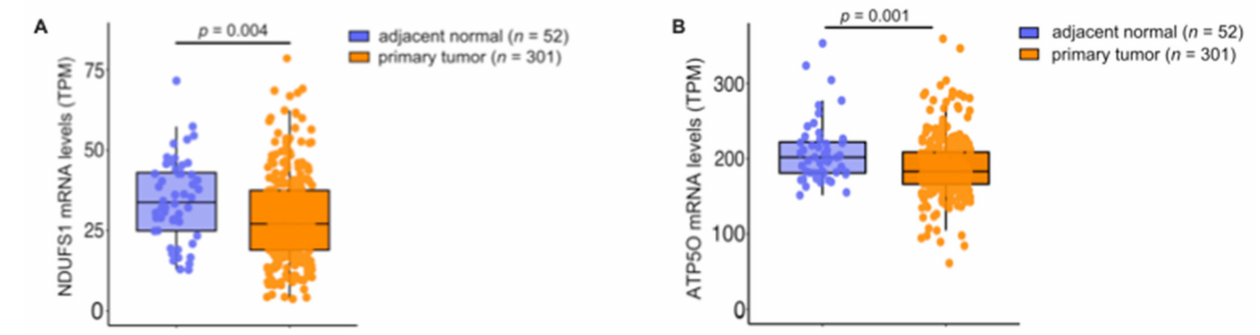
Figure A4. ( A ) NDUFS1 mRNA expression levels (TPM) analyzed from TCGA-PRAD primary tumor tissue ( n = 301) and adjacent normal tissue ( n = 52). ( B ) ATP5O mRNA expression levels (TPM) analyzed from TCGA-PRAD primary tumor tissue ( n = 301) and adjacent normal tissue ( n = 52). Data for ( A , B ) were extracted from The Cancer Genome Atlas-Prostate Adenocarcinoma data (TCGA-PRAD) collection. Representation: boxes as interquartile range, horizontal line as the